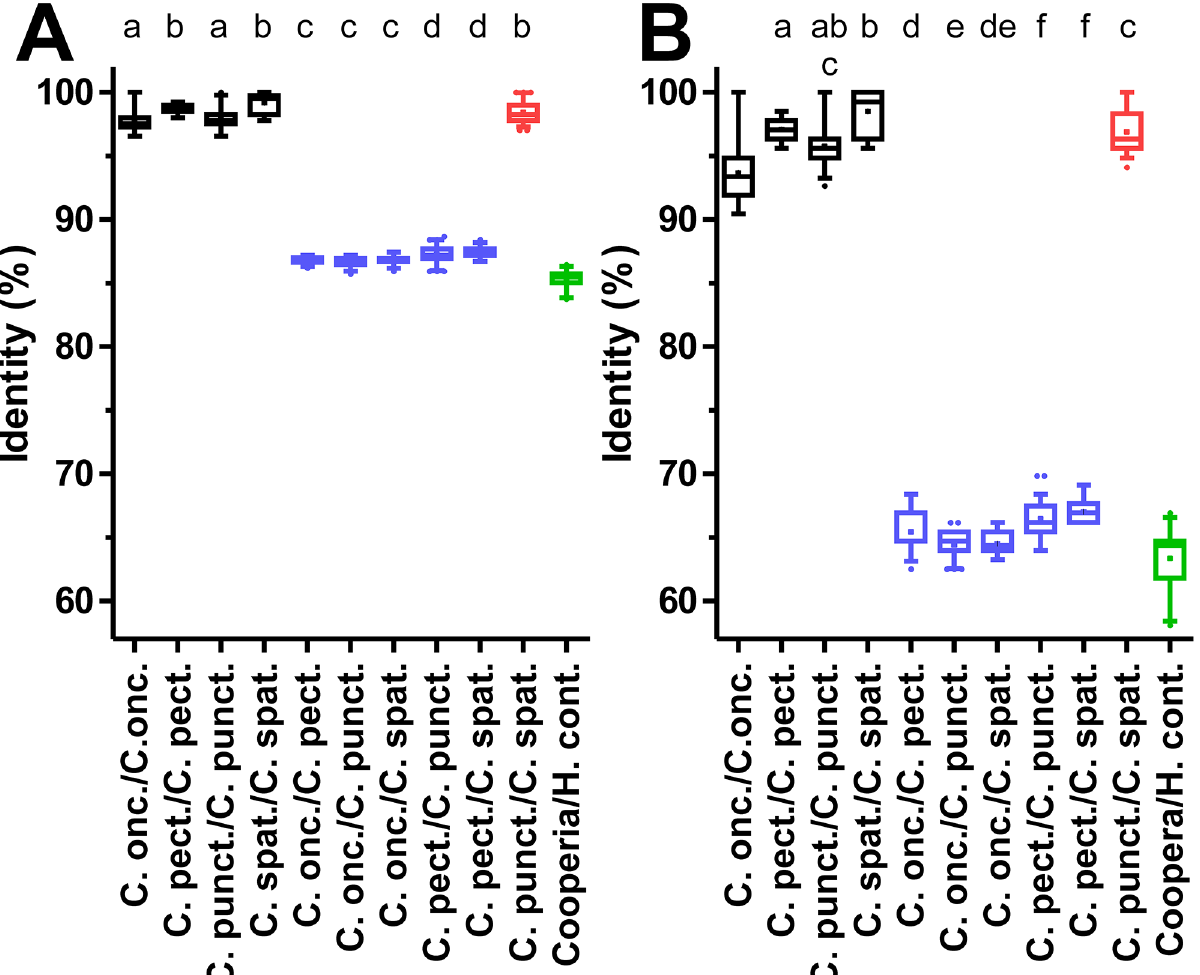
Fig 5. Pairwise sequence identities for intra- and inter-species comparisons at the mitochondrial cox-2 locus. Pairwise identities are plotted as box plots for a partial cytochrome oxidase 2 ( cox-2 ) sequence (A) and the third codon position of the same fragment (B). Whiskers indicate 5–95% quantiles with outliers represented by dots. The mean of each dataset is marked by a cross. Intra-species comparisons and inter-species comparisons within the genus Cooperia are shown in black and blue, respectively. Comparisons between C . punctata and C . spatulata are drawn in red. All comparisons between a Cooperia sequence and a representative H . contortus sequence are plotted in green. All accession numbers for sequences used in the analysis are given in S2 Table. Index letters (a-d in panel A and a-f in panel B) are used to indicate significant differences between groups as revealed by Kruskal-Wallis test followed by a Dunn’s post hoc test between all Cooperia groups. Only groups sharing no index letter are significantly different (p < 0.05).